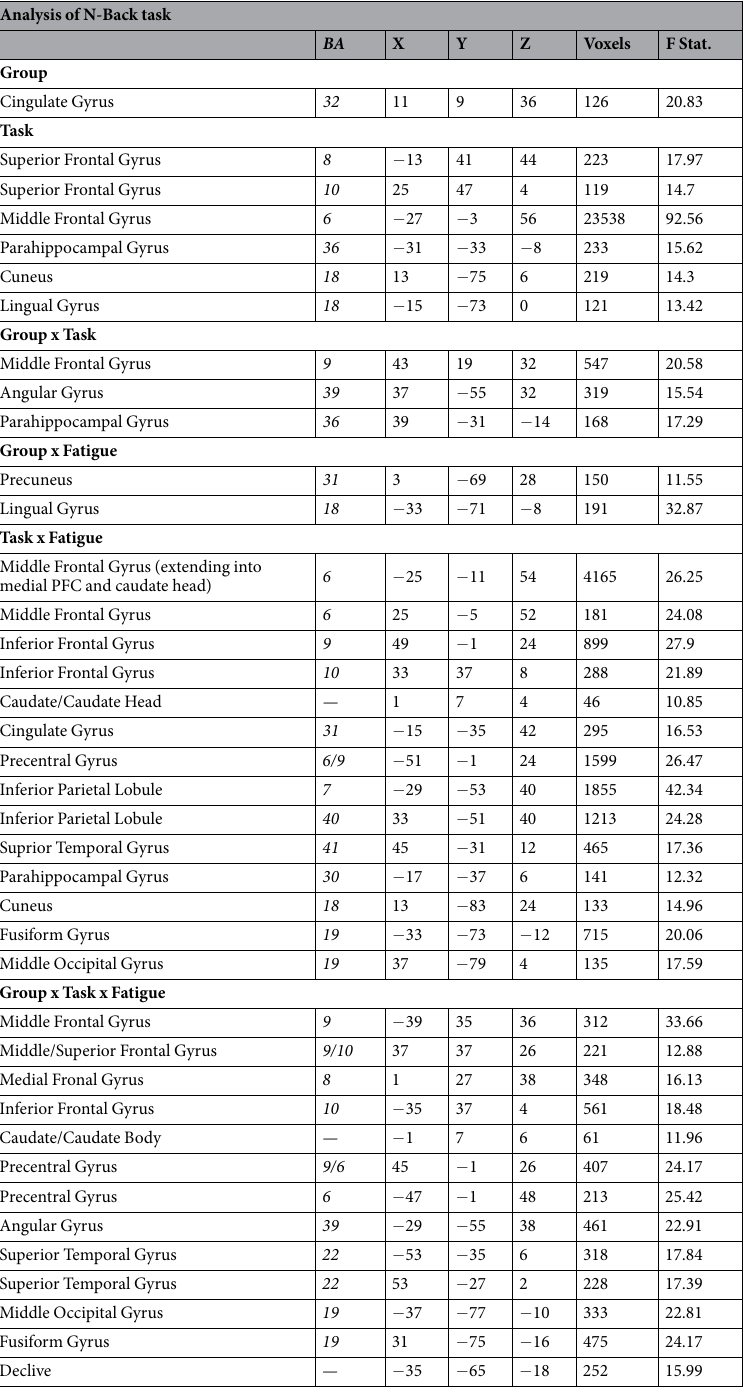
Table 1. Areas of significant brain activation for the analysis of the N-Back task. ‘BA’ denotes Broadman’s Area; ‘X’, ‘Y’, and ‘Z’ denote the location in Talairach space of the voxel in the cluster with the highest activation; ‘Voxels’ denotes the number of voxels in each cluster; ‘F-Stat.’ denotes the F-statistic associated with the voxel of highest